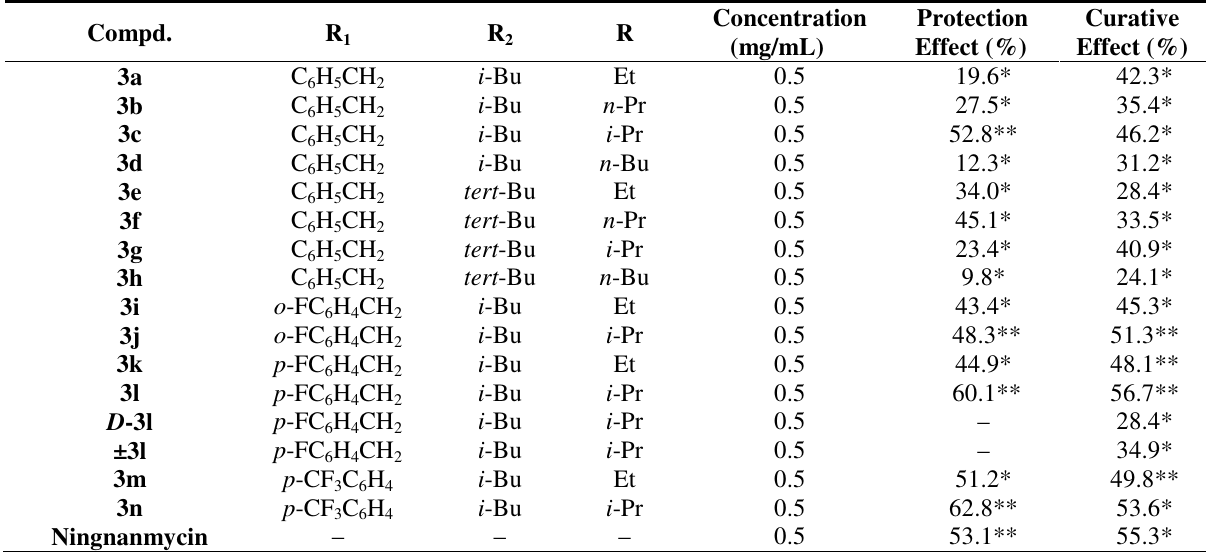
Table 3. The protection effect and curative effect of the compounds 3a-n against TMV in vivo.